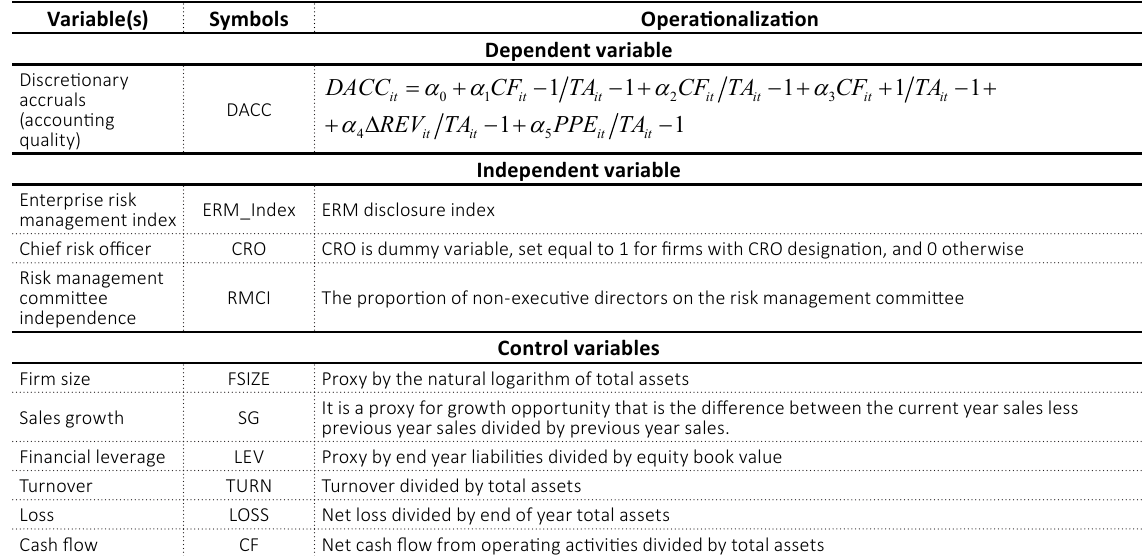
Table 1. Measurement of